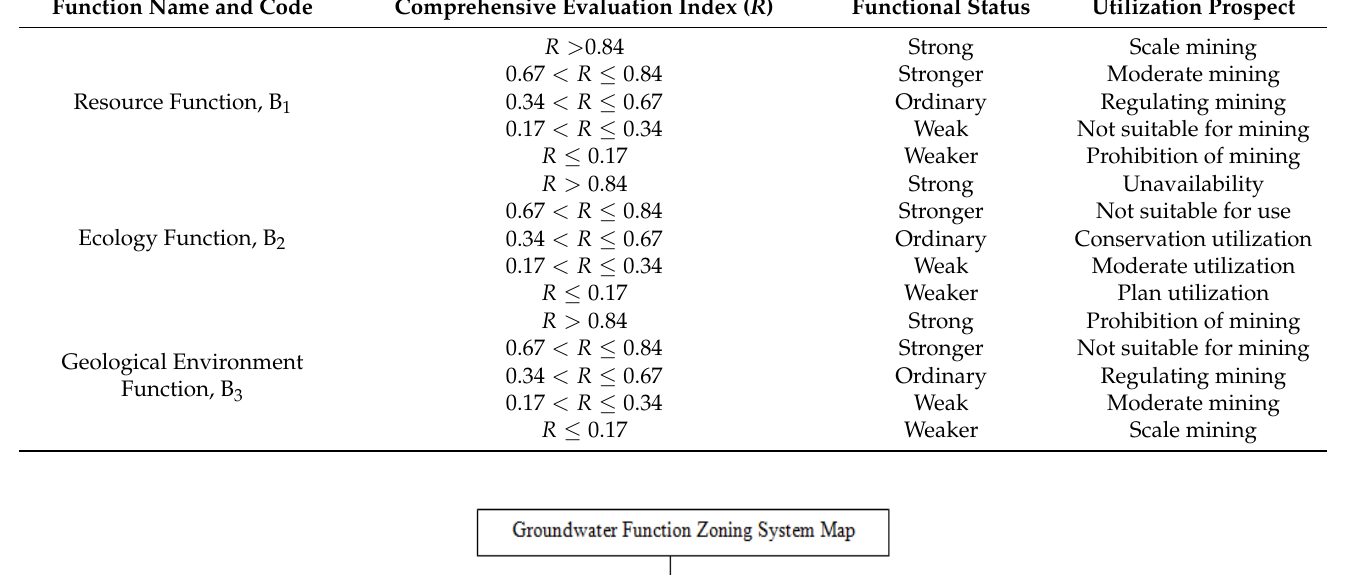
Table 2. Classification and significance of groundwater target function evaluation results.